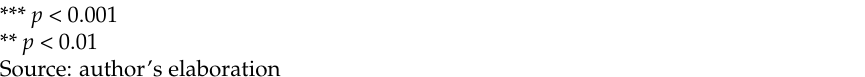
Model I Model II Robust Robust Coef. Coef. Std. Err. Std. Err. Ref.